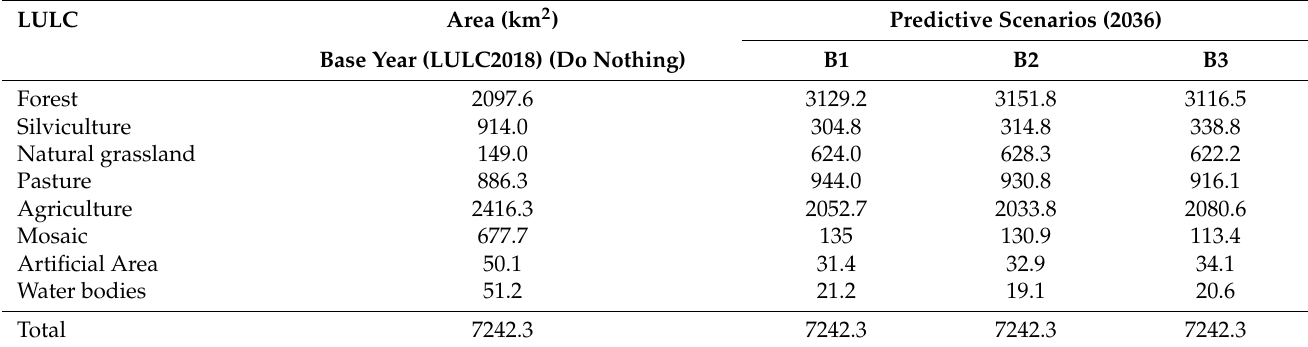
Table 11. LULC evolution trends of the predictive scenarios B.